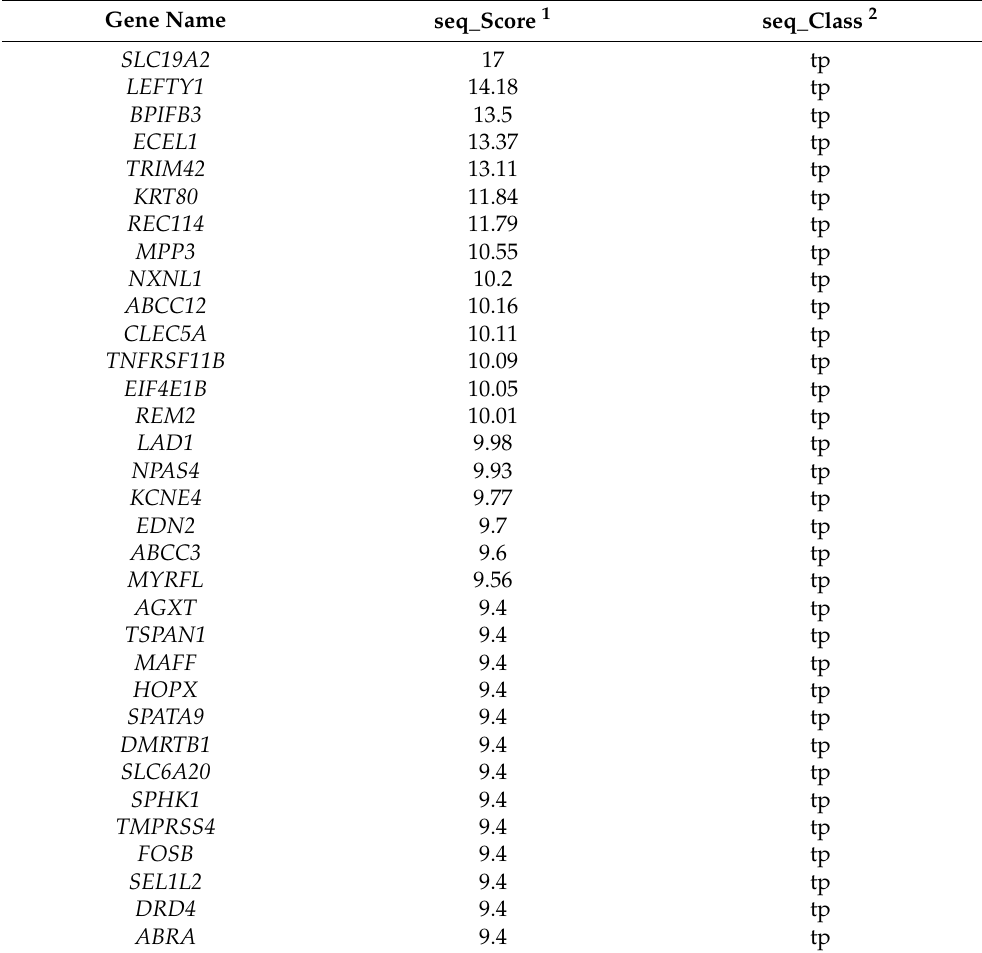
Table 3. Predicted genes with the NFIC-binding